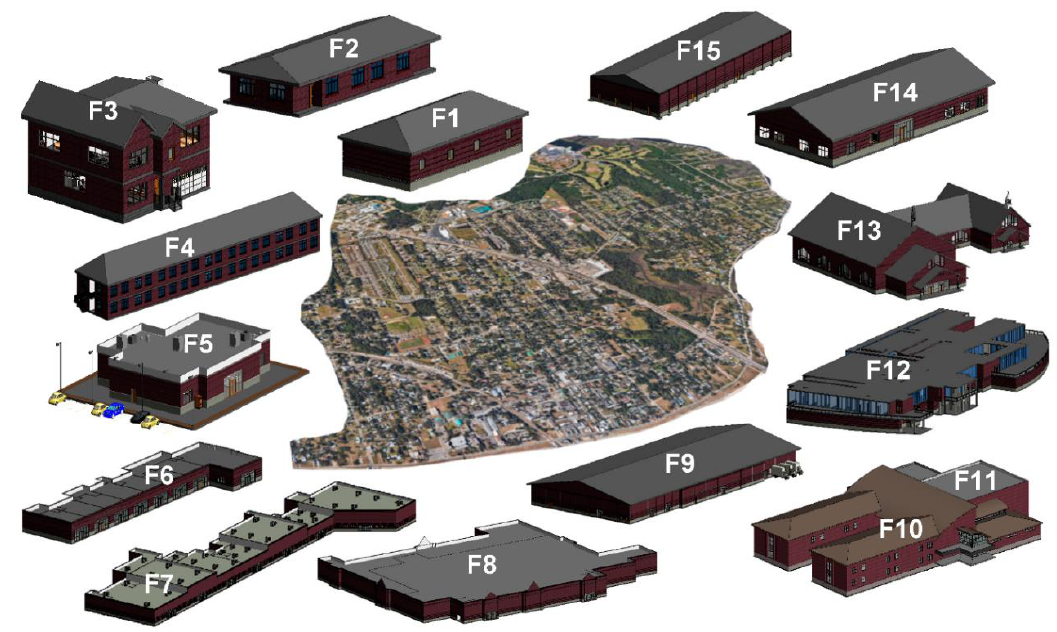
Figure 4. Schematic representation of using minimum building archetypes portfolio to model a community.